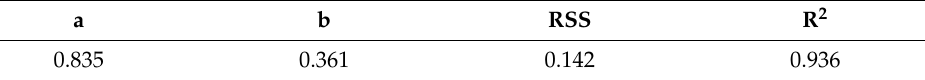
Table 11. Parameters of the regressed expression.